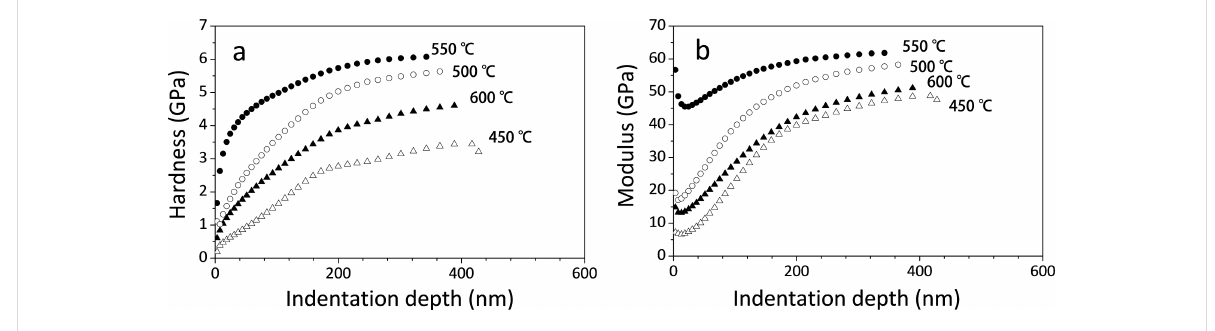
Figure 4: Nanoindentation measurement for the ICSG resists annealed at different temperatures: (a) hardness and (b) elastic modulus.